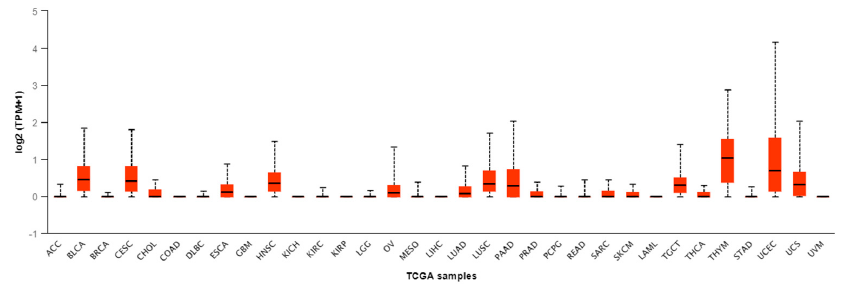
Figure 2. Expression of CGB2 in cancer, according to TCGA data.